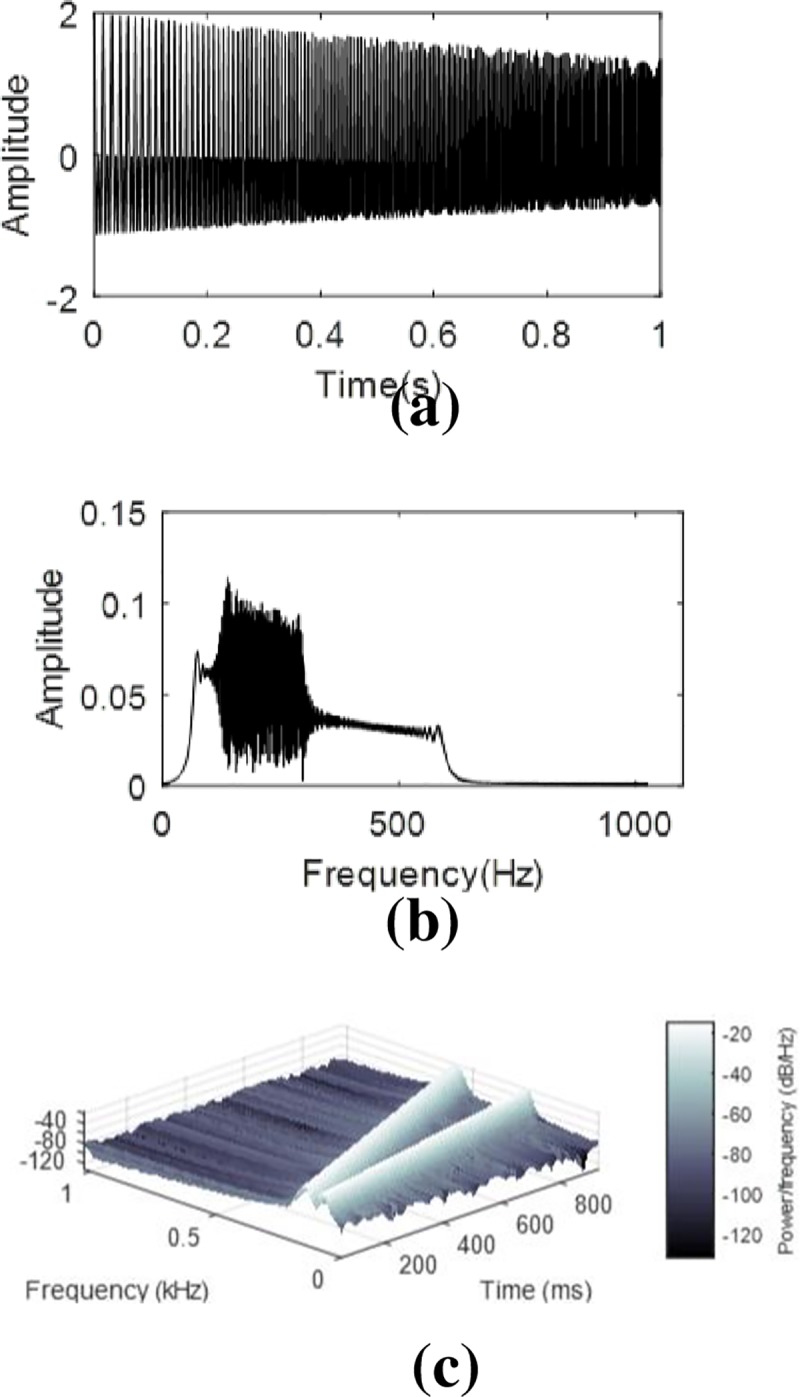
The test signal.(a) Waveform. (b) Frequency spectrum. (c) TFR with the STFT. The instantaneous frequency of s1 and s2 are f1(t) = 50+200t, f2(t) = 120+480t.